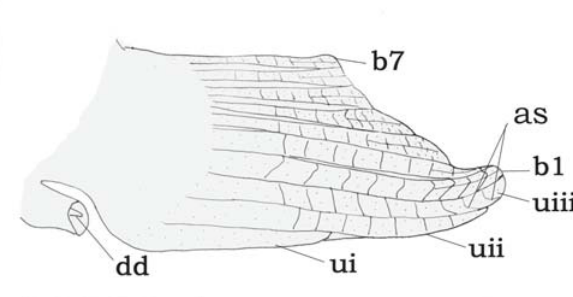
Fig. 18. Male modified anal fin of Tatia caxiuanensis , new species, MPEG 6201, 29.3 mm SL. Left side lateral view. Ab- breviations: as , antrorsely curved segment; b1 , branched first ray; b7 , branched seventh ray; dd , deferent duct; ui , un- branched first ray; uii , unbranched second ray; uiii , un- branched third ray. Scale bar =1.0